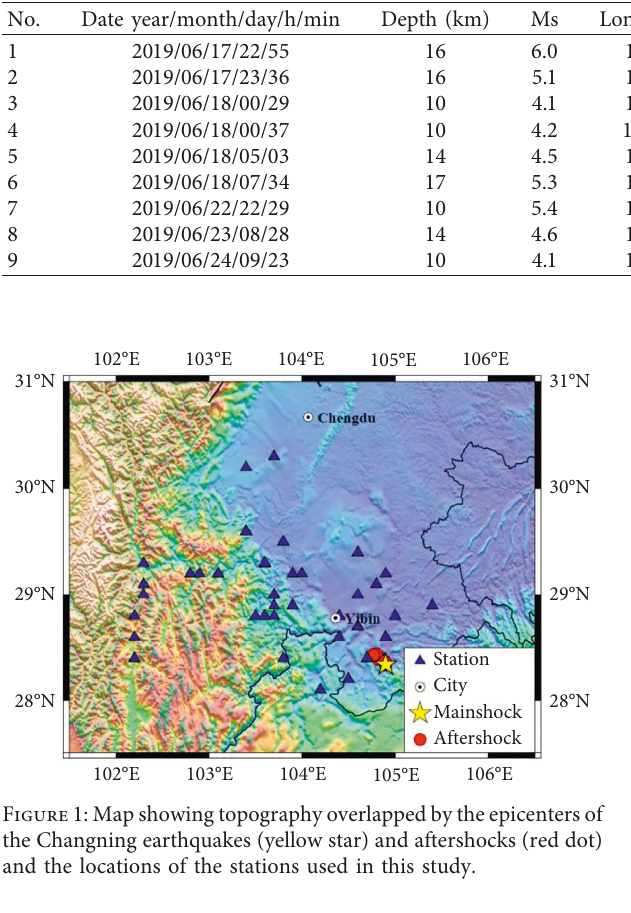
Table 1: Parameters of selected earthquakes used in this study.